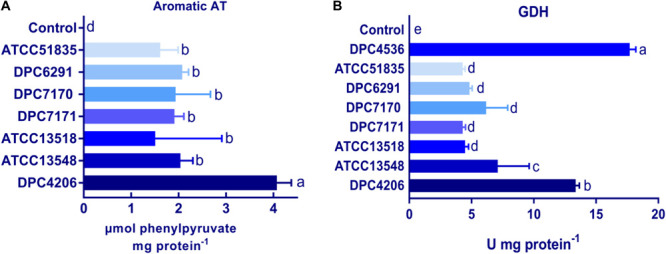
(A) Aromatic aminotransferase (ArAT) activities of M. caseolyticus subsp. caseolyticus strains along with Lactobacillus paracasei DPC4206 determined by measuring the absorbance of phenylpyruvate, the final product of transamination between phenylalanine and α-ketoglutarate. Results are expressed as μmol of released phenylpyruvate/ (min*mg of protein). (B) Glutamate dehydrogenase (GDH) activities of strains of M. caseolyticus subsp. caseolyticus along with Lactobacillus paracasei DPC4206 and DPC 4536 by following change in absorbance during a reaction catalyzed by GDH enzyme in which glutamic acid is converted to α-ketoglutarate in the presence of NAD+. Results are presented as Units of enzyme activity per mg of protein, where the unit represents the amount of enzyme giving an increase of absorbance of 0.01 per 1 min. Bars sharing the same letter show no significant difference according to least significant difference (LSD) test (P < 0.05). Strains were analyzed in triplicate. Error bars present standard deviation.